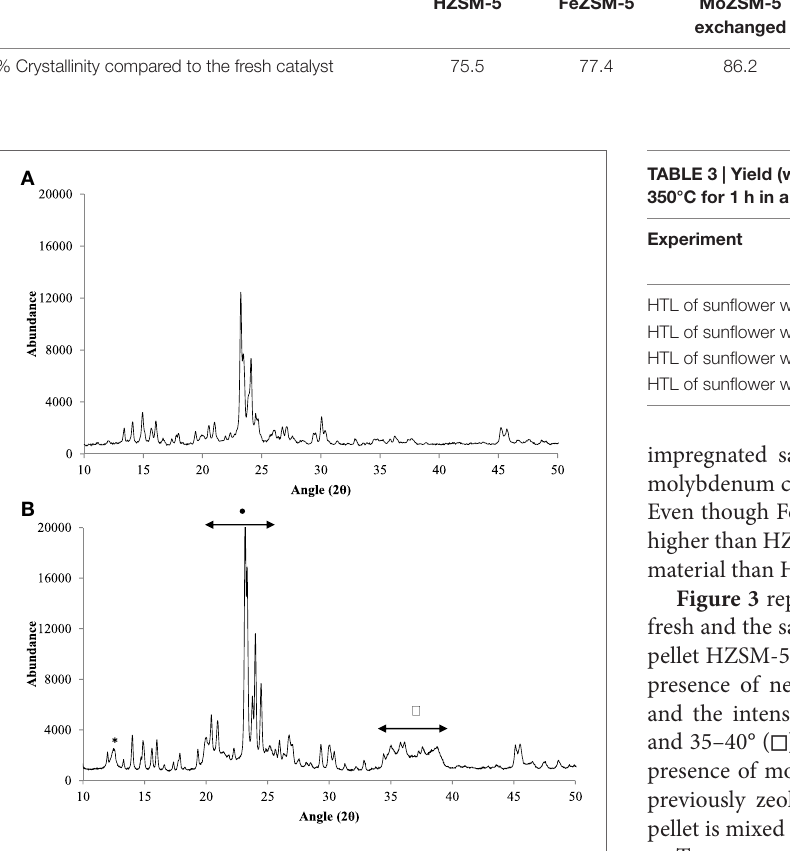
FigUre 3 | Overlay of the fresh (a) and used (B) pellet 40–40 kaolin-hZsM-5